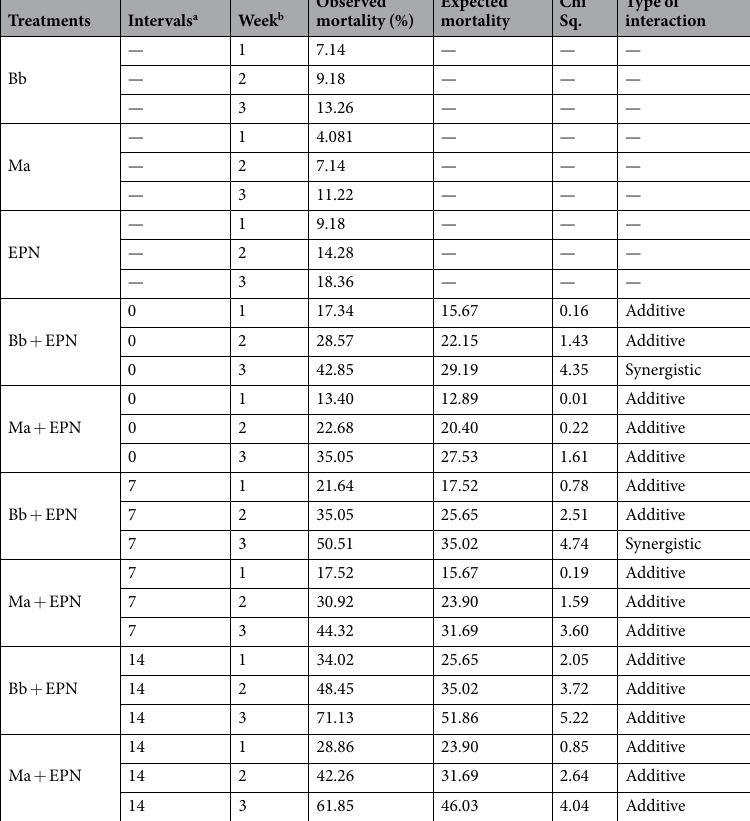
Table 3. Mean mortality (% ± SE) of 6 th instar larvae of Rhynchophorus ferrugineus treated with Beauveria bassiana, Metarhizium anisopliae and Heterorhabditis bacteriophora. B. bassiana and M. anisopliae were used each @ 1 × 10 6 conidia ml − 1 and H. Bacteriophora was applied @ 100 IJs ml − 1 (Bb: Beauveria bassiana , Ma: Metarhizium anisopliae , EPN: Heterorhabditis bacteriophora , IJs: Infective Juveniles). a Intervals between the application of EPFs and EPNs. b Week after fungal